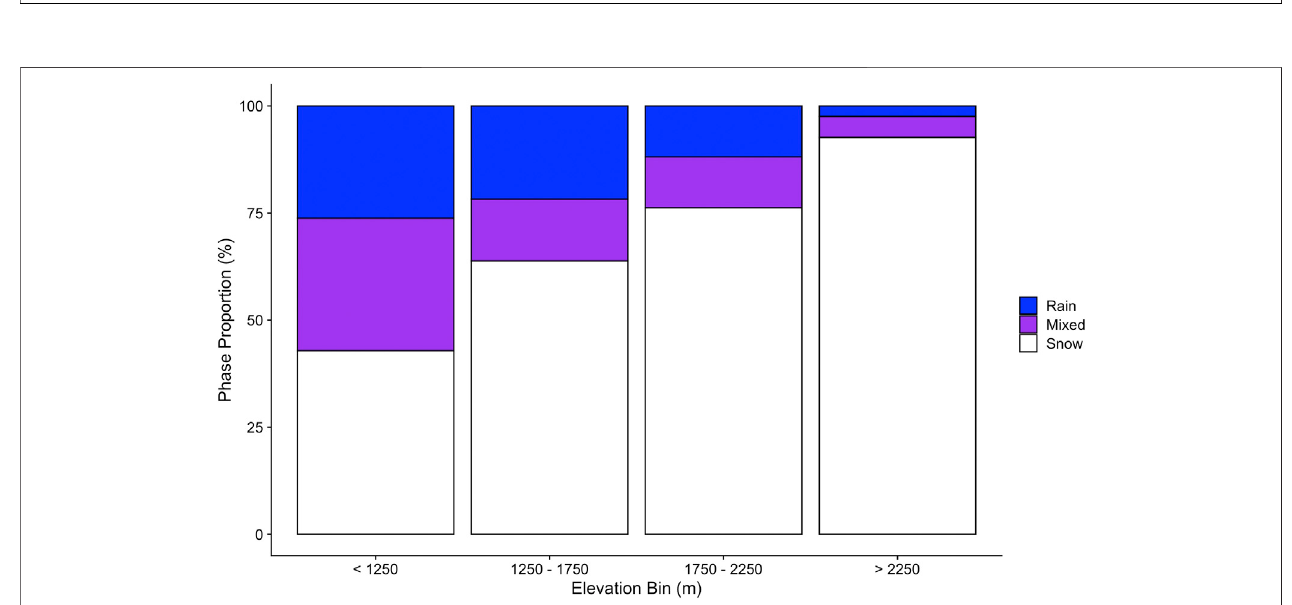
FIGURE 7 | The proportion of each precipitation phase reported per 500 m elevation